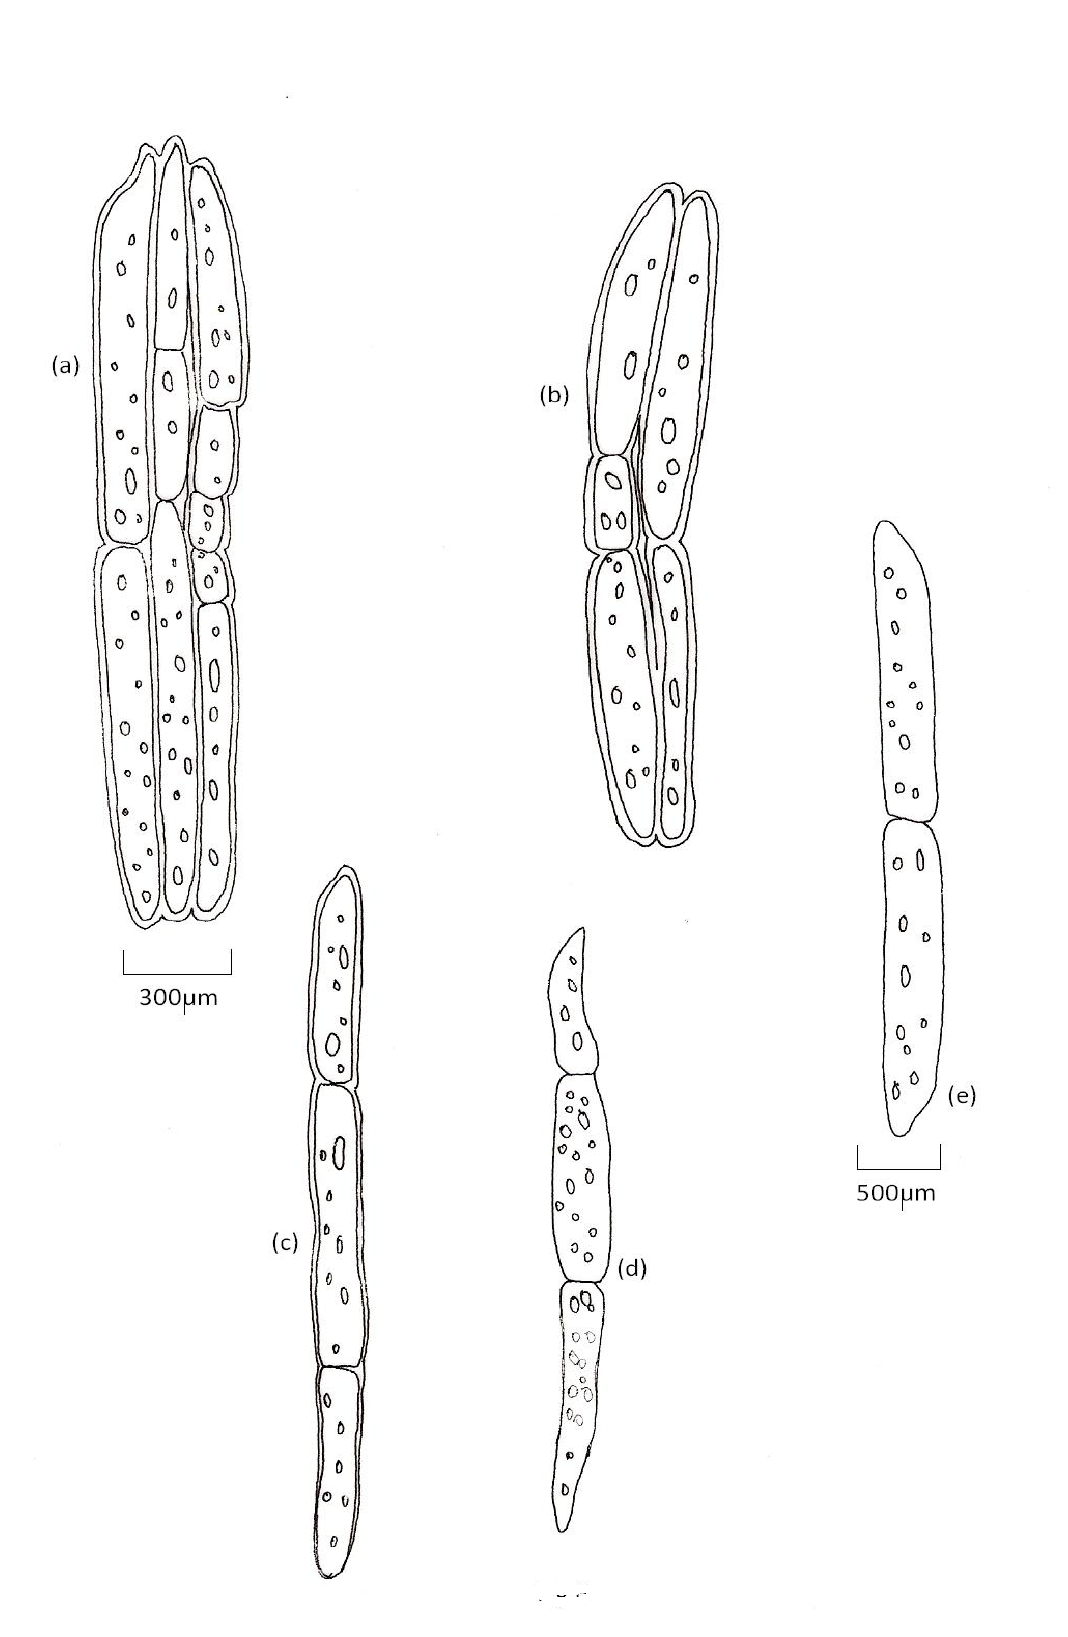
Fig. 6. Diagrammatic illustration of parenchyma cells in Annona muricata ; Diagram a-b: Ray parenchyma cells in Annona muricata ; Diagram c-e: Axial parenchyma cells in Annona